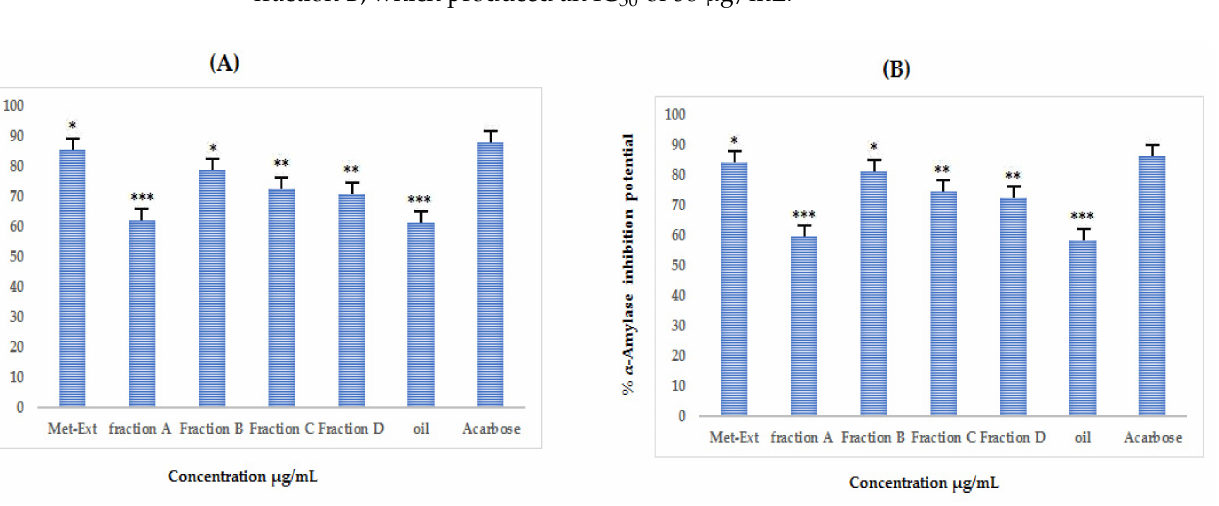
Figure 8. ( A ) % α -glucosidase inhibition potential and ( B ) % α -amylase inhibition potential of crude extract, purified fractions (A, B, C, and D), and oil fraction of A. articulata at different concentrations. The data are represented as mean ± SEM, n = 3. Values are significantly different as compared to positive control * p < 0.05, ** p < 0.01, *** p <